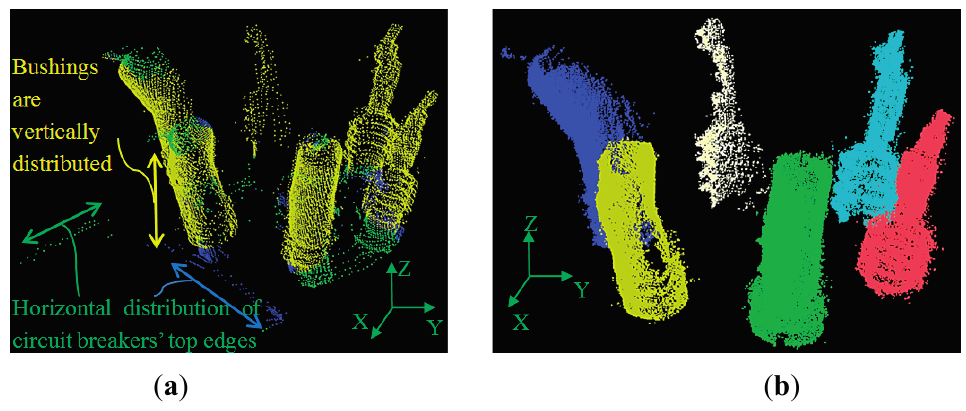
Figure 12. Bushings (yellow) are vertically distributed while circuit breakers edges (blue and green) are distributed in horizontal directions ( a ). Each individually recognized bushing is indicated by a different color ( b ).